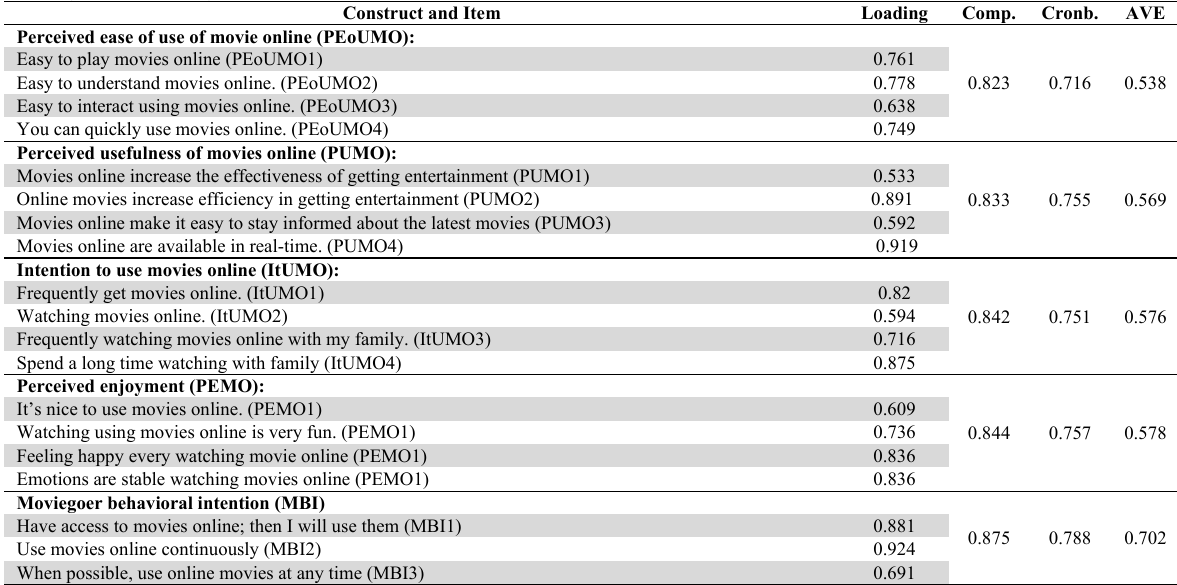
Validity and reliability of the measurement result